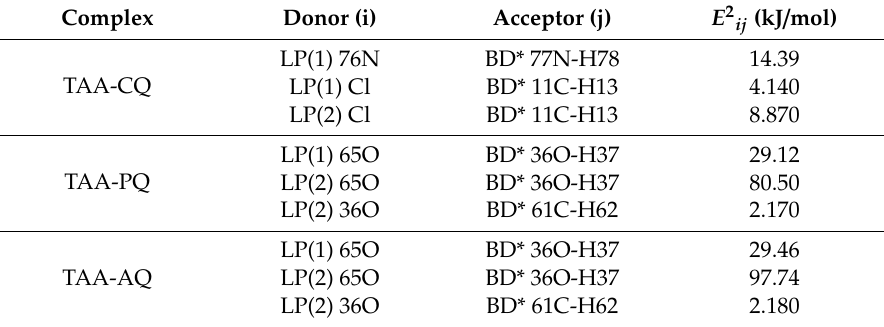
Table 4. The second order perturbation theory for the drugs-Acrylamide trimer by using Fock matrix from Natural Bond Orbital (NBO) calculation at the wb97xd / 6-31G ++ (d,p) theory level.